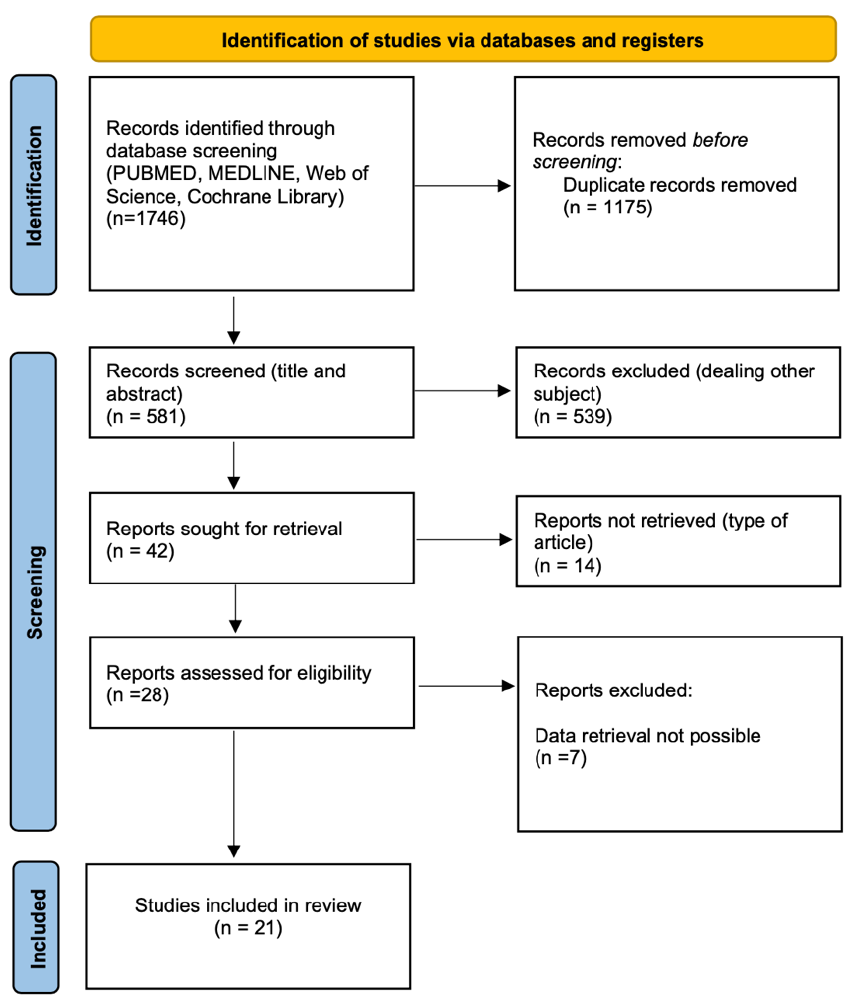
Figure 1. Systematic search process.